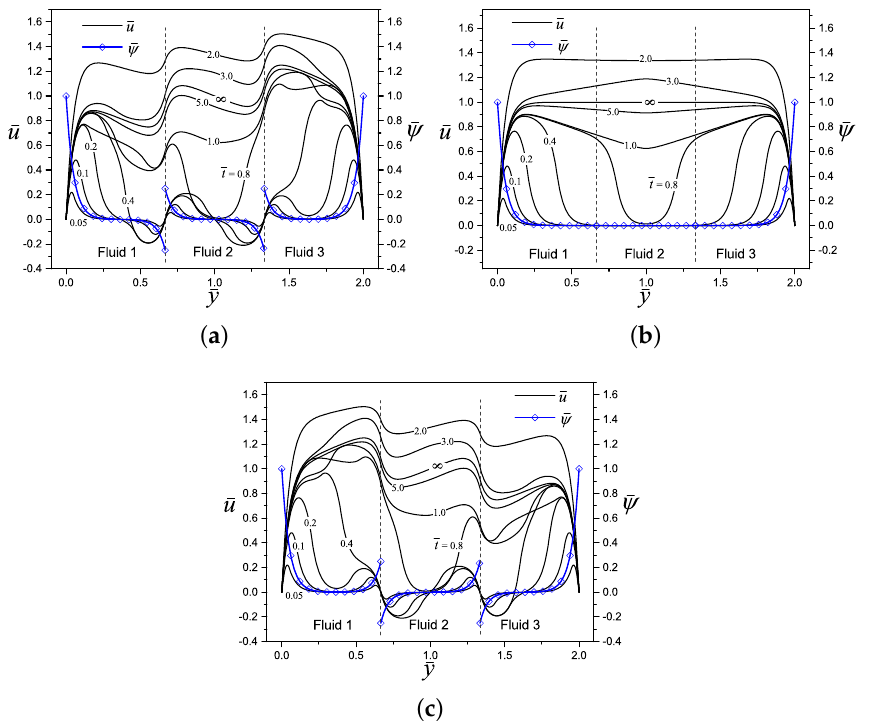
Figure 4. Dimensionless electric potential and velocity profiles of an electroosmotic flow with n = 3, ( ¯ y 1 = 2/3, ¯ y 2 = 4/3), ¯ κ n = 20, ¯ ρ n = ¯ η n = ¯ (cid:101) n = ¯ λ n = 1, for: ( a ) ∆ ¯ ψ n = 0.5, ( b ) ∆ ¯ ψ n = 0, and ( c ) ∆ ¯ ψ n = −